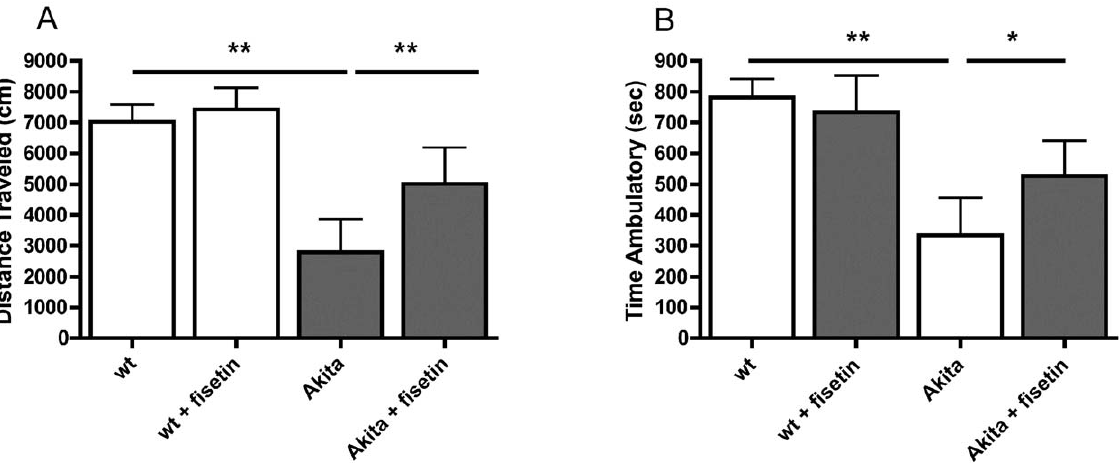
Figure 2. Fisetin reduces an experimental index of anxiety in Akita mice. Male Akita mice were fed control diet or fisetin (0.05%) diet for 18 weeks beginning at 6 weeks of age. Locomotor activity was measured in the open field test. Decreased locomotor activity is an indicator of elevated anxiety that is characteristic of diabetics in poor glycemic control. Fisetin restored (A) distance traveled and (B) time ambulatory to nearly control levels. All data are mean 6 SD of n =5–7/group. *( p , 0.05) and **( p , 0.01) indicate significantly different from wild type or Akita alone as determined by ANOVA followed by Tukey’s post test.